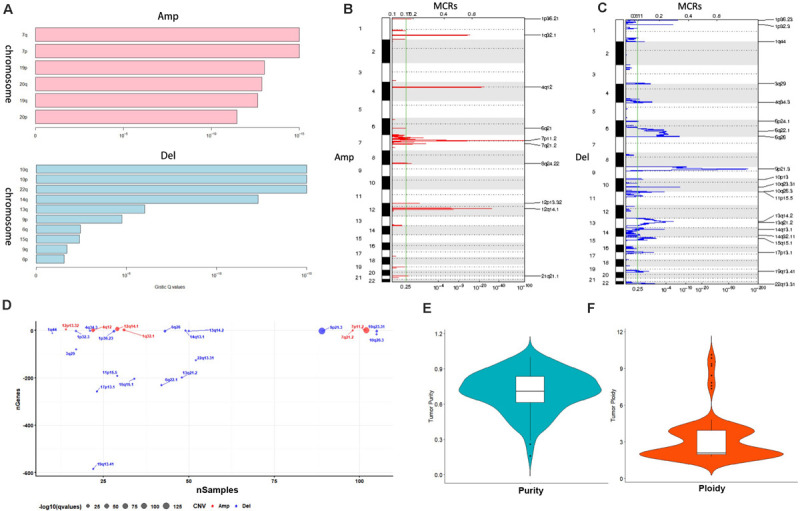
Copy number variation analysis. (A) GISTIC analysis for enrolled samples, upper panel: amplification of chromosome arm, lower panel: deletion of chromosome arm. (B,C) Distribution of minimal common regions (MCRs). (D) The number of genes in minimal common regions (the number of genes in the missing region is represented by a negative value). (E,F) Purity and ploidy analysis.